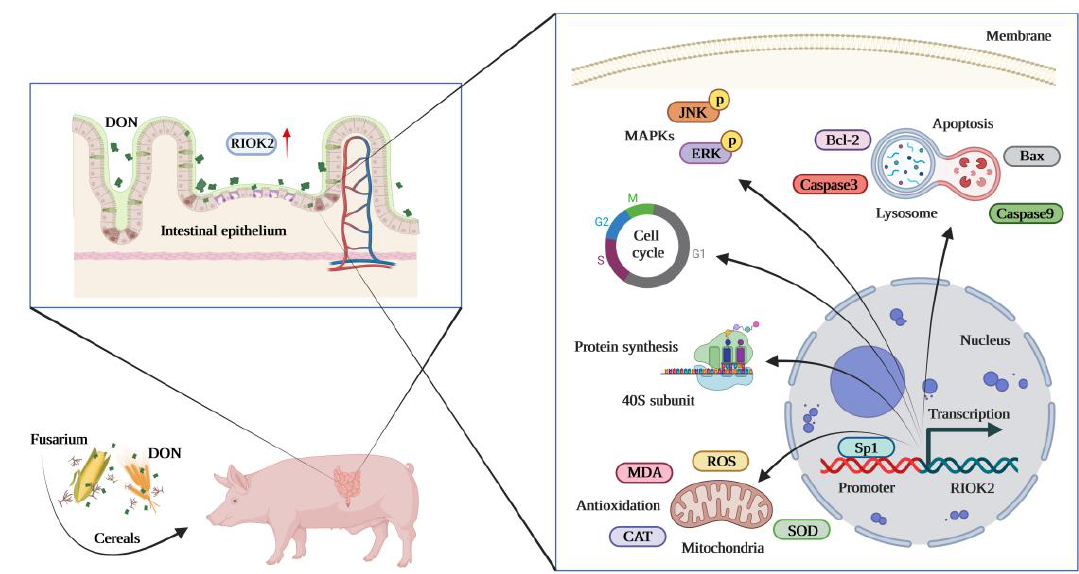
Figure 6. Schematic diagram of the RIOK2 gene regulating the cytotoxic effects induced by DON in IPEC-J2. DON enters the small intestines of pigs by ingesting cereals infected with Fusarium . RIOK2 is highly expressed during DON exposure and improves cytotoxicity resistance by affecting cell proliferation, apoptosis, antioxidant capacity, and activation of the MAPK signaling pathway in IPEC-J2. Moreover, the transcription factor Sp1 regulates the expression of RIOK2 by binding to the promoter region. This mechanism determines the action of RIOK2 in the responses of IPEC-J2 to DON exposure. Created with BioRender.com.